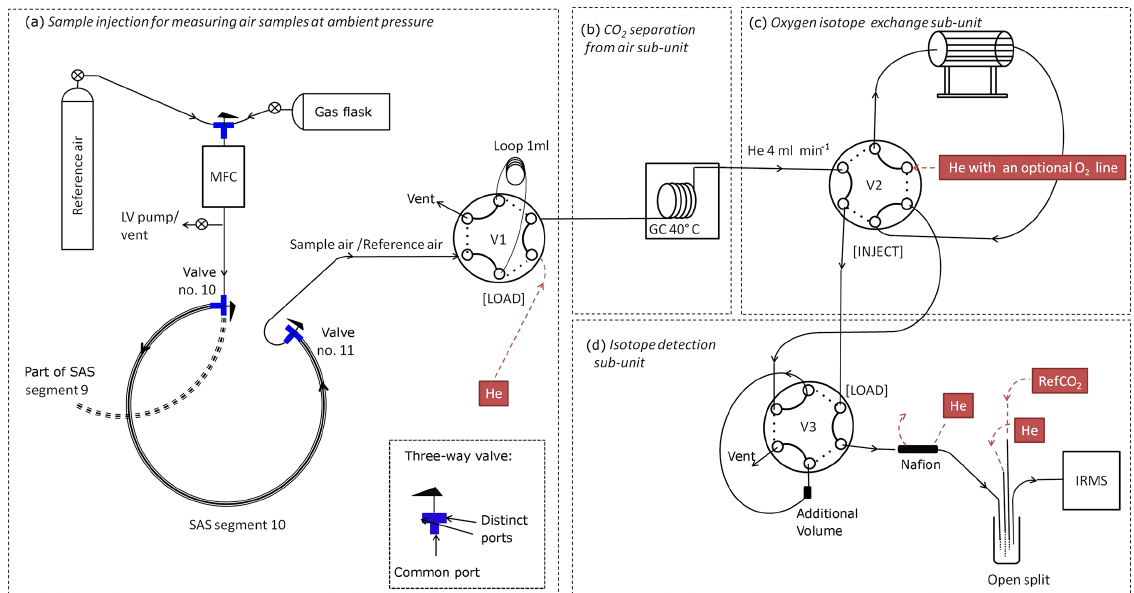
Figure 3. Schematic diagram of the CF-IRMS analytical system for complete isotope analysis (including (cid:49) 17 O) of stratospheric CO 2 . The system is divided into four units: (a) sample injection, (b) gas chromatographic column (GC) to separate CO 2 from air and N 2 O, (c) optional oxygen isotope exchange unit and (d) isotope detection unit including open split interface and isotope ratio mass spectrometer (IRMS). MFC is mass flow controller, V1–V3 are Valco valves, RefCO 2 is Utrecht working reference CO 2 , the crossed circles are conventional valves and the blue T’s are the three-way valves. The SAS three-way valves are normally closed but here they are shown in the sample admission